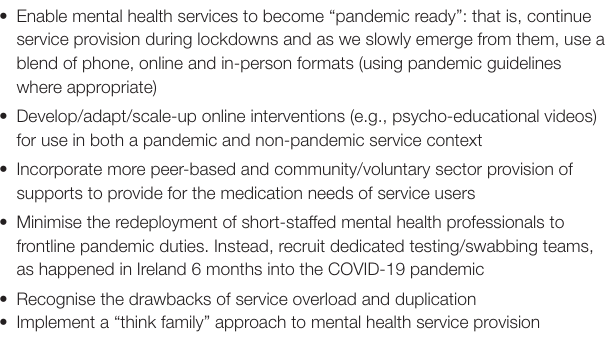
TABLE 1 | Recommendations for mental health services in current pandemic and future non-pandemic contexts. • Enable mental health services to become “pandemic ready”: that is, continue service provision during lockdowns and as we slowly emerge from them, use a blend of phone, online and in-person formats (using pandemic guidelines where